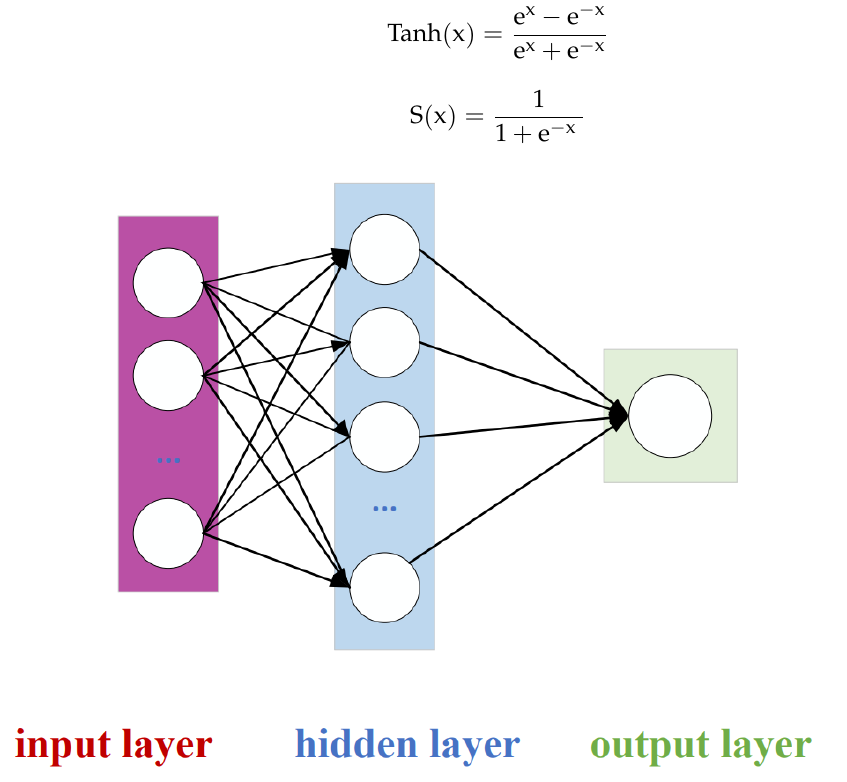
Figure 2. Schematic diagram of artificial neural network.